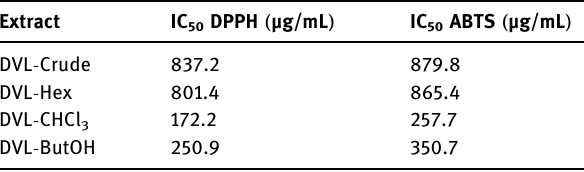
Table 2: IC 50 of DVL extract and